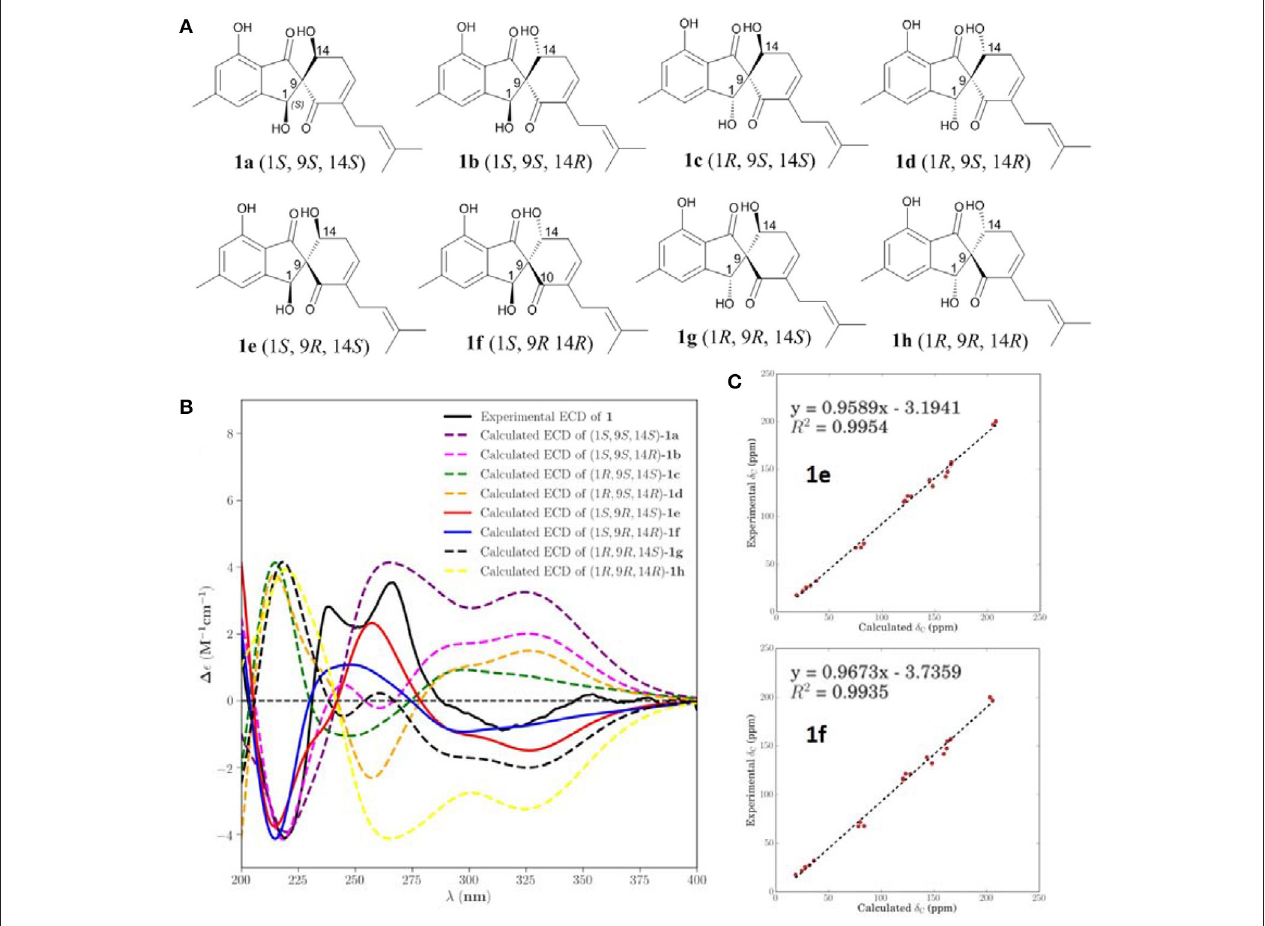
FIGURE 3 | Calculated ECD and NMR studies of 1 . (A) Eight possible stereoisomers (a-h) of 1 . (B) Calculated ECD spectra of configurations a - h were compared with the experimental ECD spectra. (C) Linear regression fitting of calculated 13 C-NMR chemical shifts of 1e and 1f with experimental values.